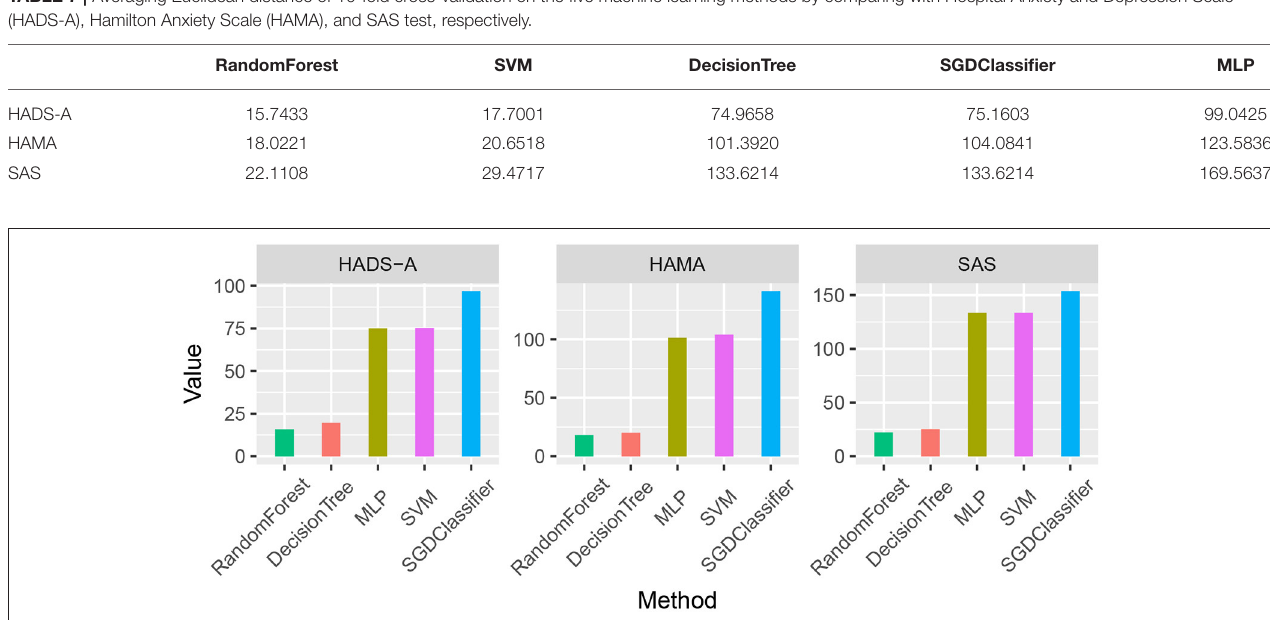
FIGURE 1 | Averaging Euclidean Distance comparison of the five machine learning methods by Hospital Anxiety and Depression Scale (HADS-A), Hamilton Anxiety Scale (HAMA), and SAS tests, respectively.